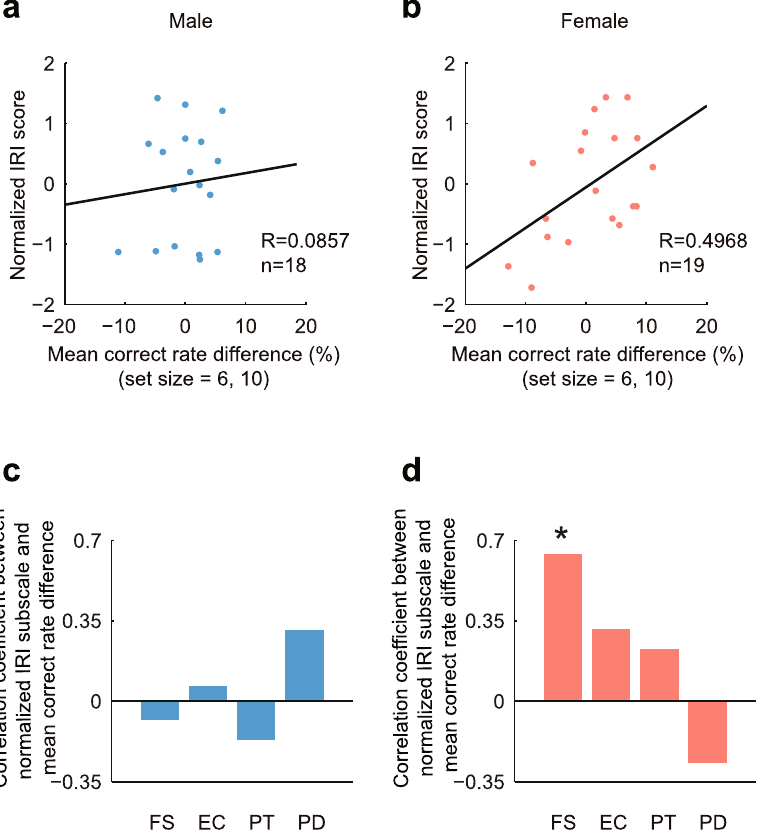
Figure 3. Empathy skill-dependent modulation of working memory in the upcoming working memory task. (a,b) The correlations between normalized IRI scores and mean correct rate differences for males (a) and females (b) . The mean correct rate differences significantly correlated with normalized IRI scores for females (R = 0.4968, P = 0.0305), but not for males (R = 0.0857, P = 0.7353). Solid lines represent linear regression. (c,d) The correlations between four IRI subscales and the mean correct rate differences. For males, only PD showed a relatively high, but non-significant correlation (c) . For females, FS significantly correlated with the mean correct rate differences ( d , R = 0.6384, P =